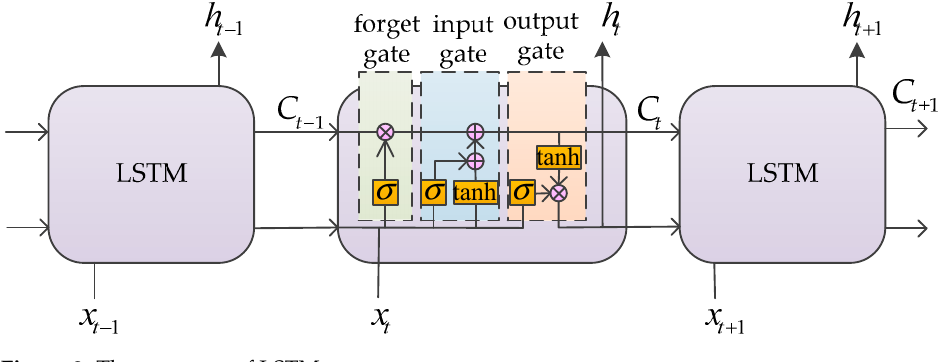
Figure 2. The structure of